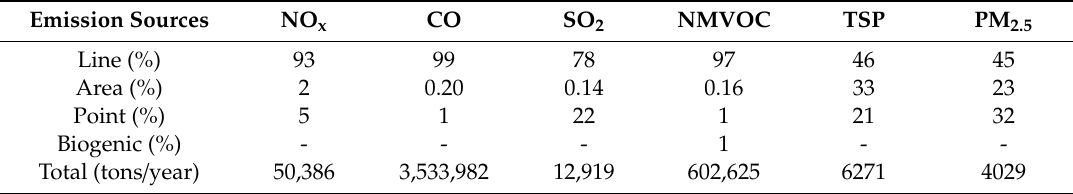
Table 5. The proportion of source types in total emissions in HCMC in 2017